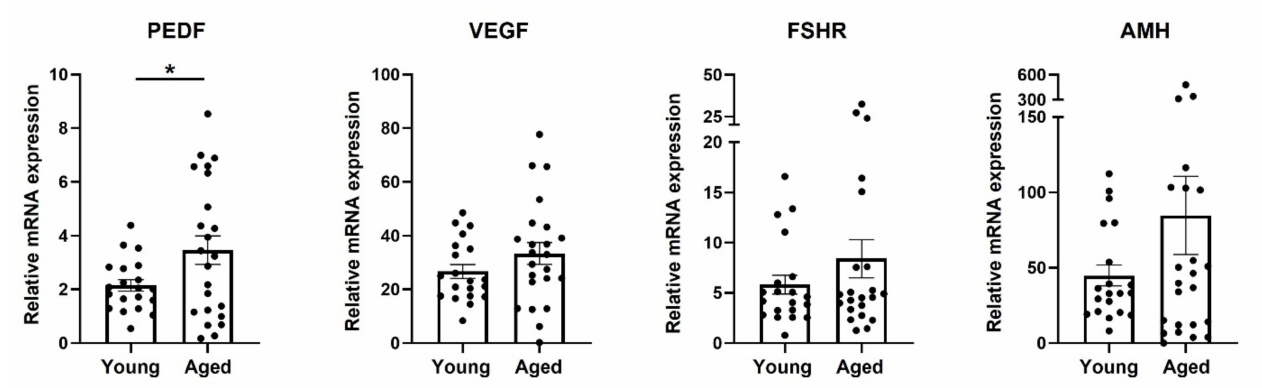
Figure 1. mRNA expression of selected genes in mouse granulosa cells. Mouse granulosa cells were isolated from individual young (“Young”; 6–8 weeks old) and RA (“Aged”; 40–46 weeks old) ICR female mice, primed for 48 h with PMSG (5IU or 7.5 IU, respectively). Cells were then subjected to qPCR analysis of PEDF, VEGF, FSHR, and AMH expression. Number of mice in each group: n > 15; each black circle represents one mouse. Data are presented as mean ± SEM. Results were analyzed by Student’s t -test with Welch’s correction, * pv < 0.05.